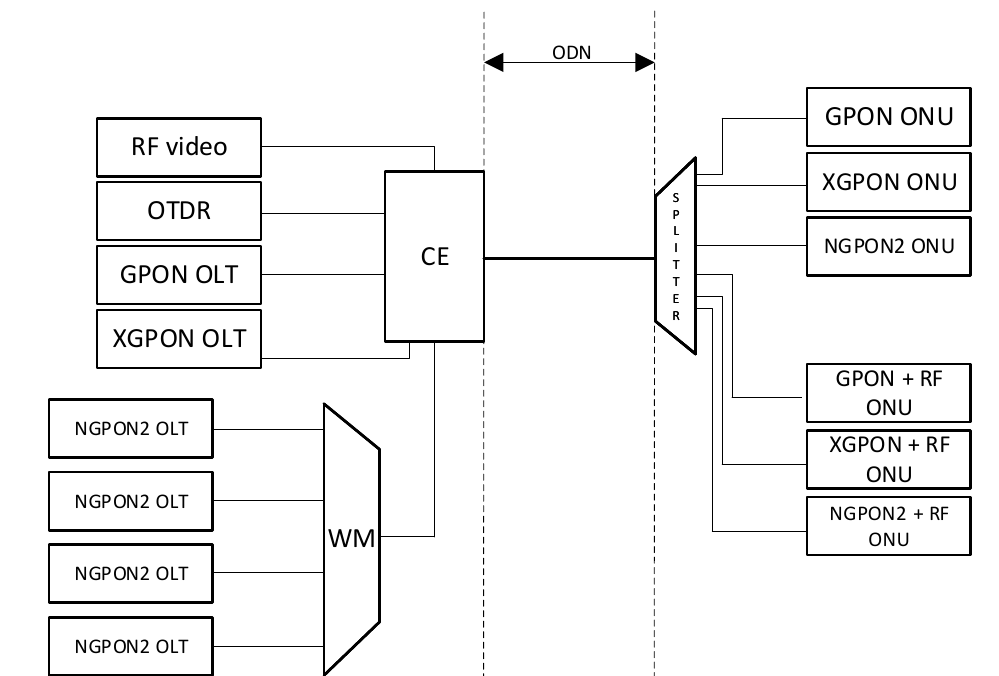
Figure 2. Principle of NG-PON2 coexistence